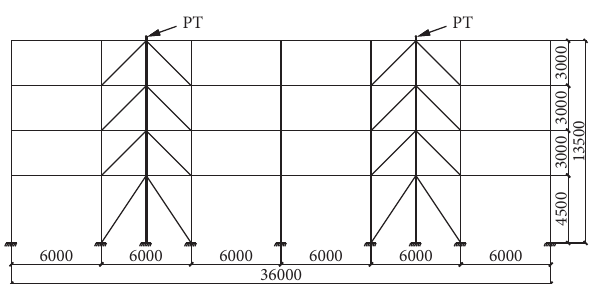
Figure 4: Elevation of the SC-CBF structure.